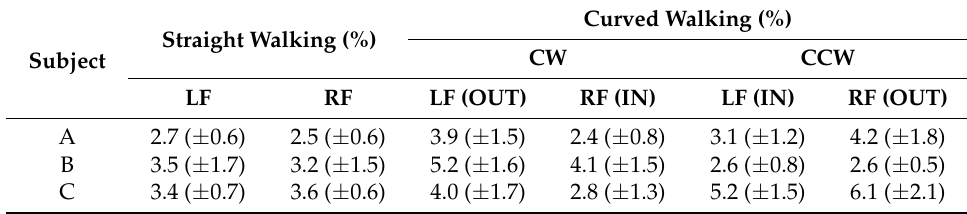
Table 2. Root-mean-square error (%RMSE) of measured vertical ground reaction force (vGRF) comparing the Nintendo Wii Balance Board (WBB) to the force plate.